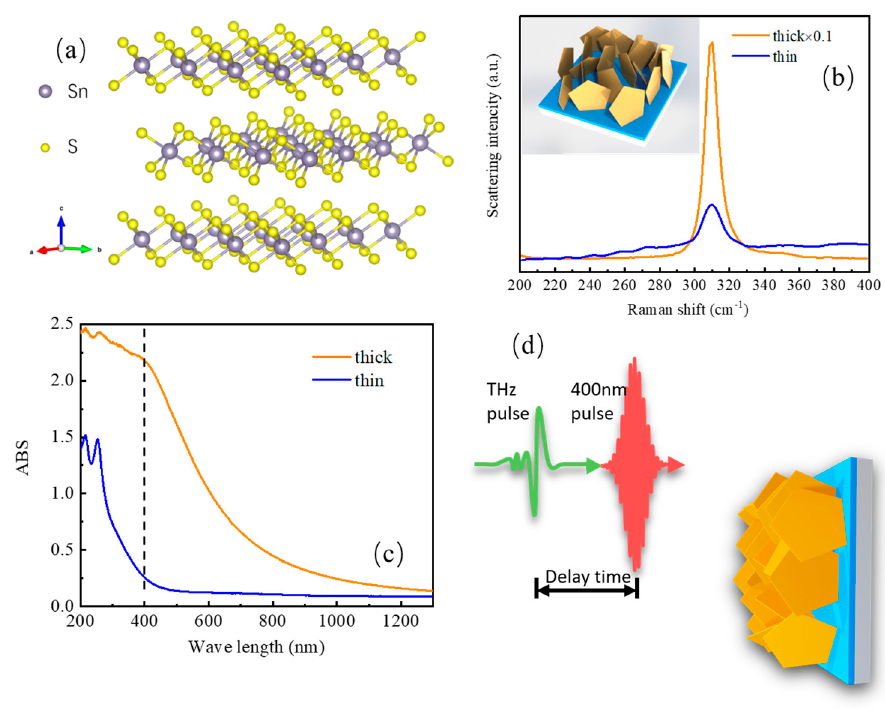
Figure 1. ( a ) The atomic structure of SnS 2 . ( b ) Raman spectra of SnS 2 films with different thickness, inset shows the schematic diagram of SnS 2 nanoflakes. ( c ) UV-visible absorption spectra of the thick and thin films of SnS 2 , respectively. ( d ) Schematic of optical-pump THz probe spectroscopy for transient THz PC measurements.